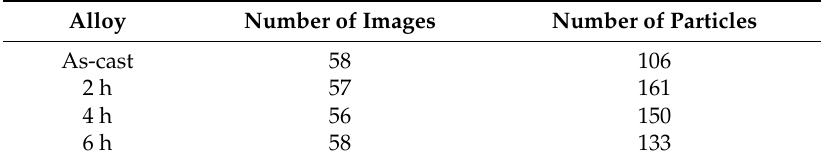
Table 2. The number of images processed and the number of particles measured for each condition.